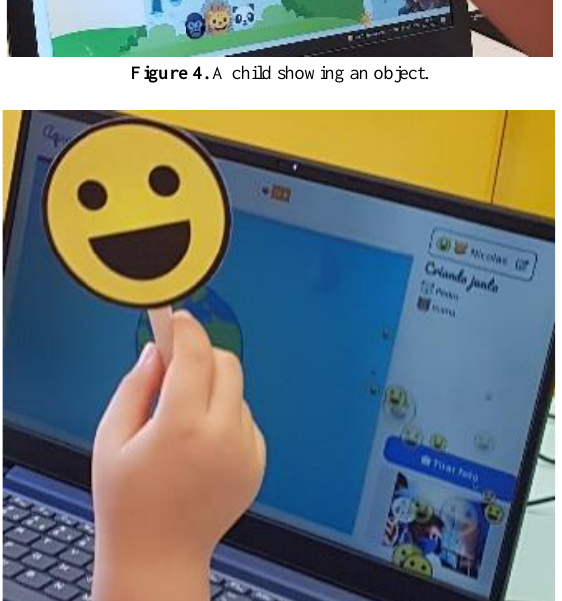
Figure 5. A child expressing affectively